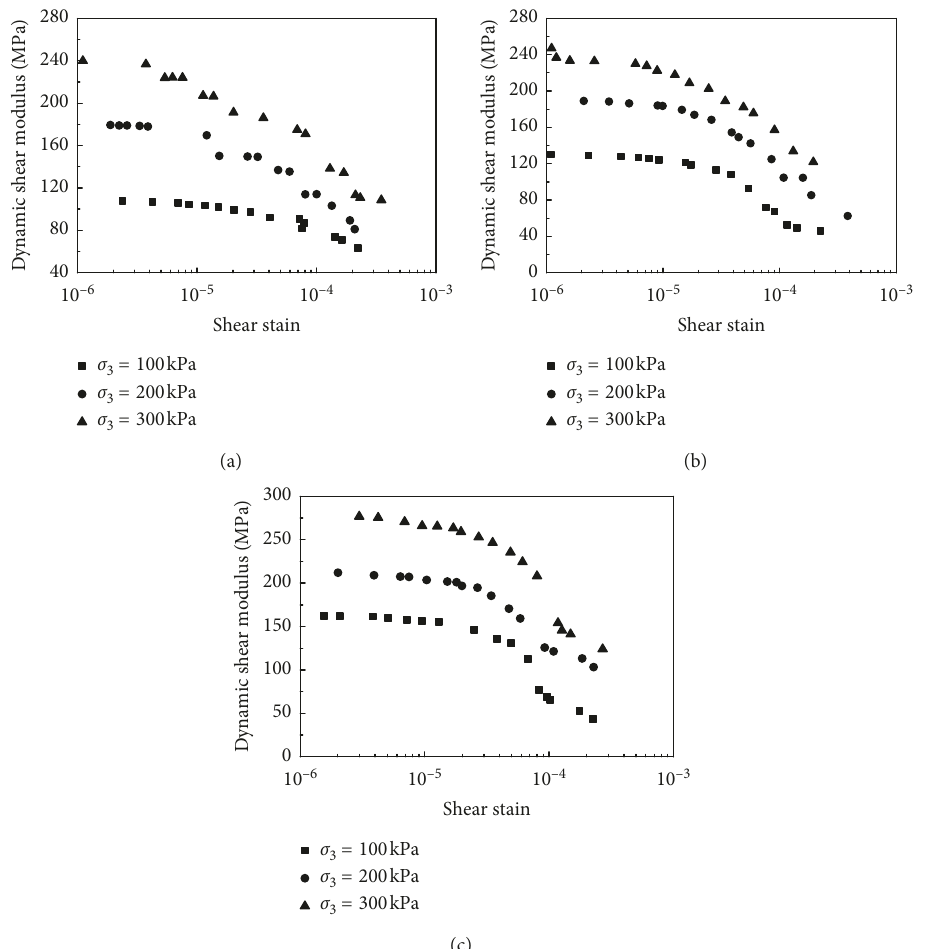
Figure 8: Effect of confining pressure on the G - c curve of steel slag: (a) D